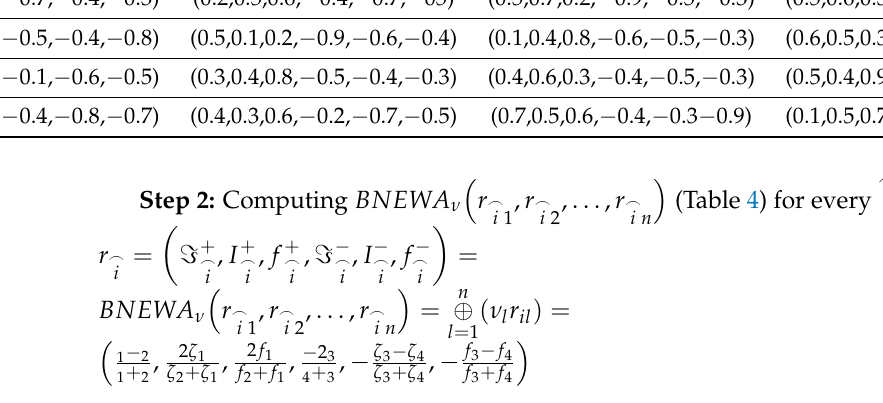
Table 4. A collective BN decision matrix